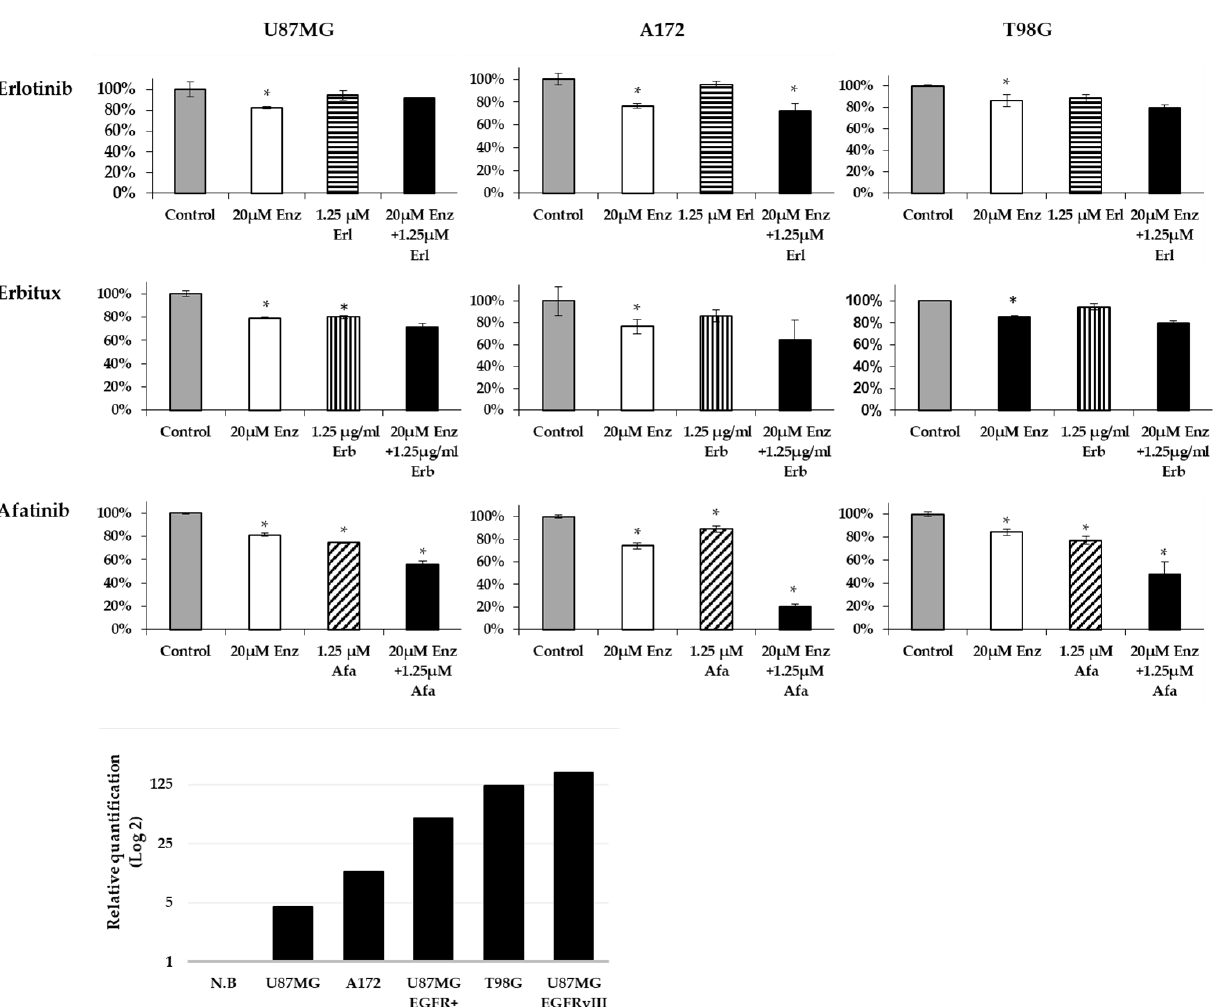
Figure 7. The combination effect of an AR antagonist and EGFR inhibitors on glioblastoma cell lines. ( A ) U87MG, A172, and T98G glioblastoma cells were treated for 72 h with EGFR inhibitors (striped columns): erlotinib (Erl), erbitux (Erb), afatinib (Afa), or the AR antagonist, enzalutamide (Enz; white columns), alone or in combination (black columns). Cell density is expressed as the percentage of cells treated with vehicle (gray columns). All experiments were repeated at least three times. The results are the mean ± SD. * p < 0.05 indicates significant results of each treatment compared to vehicle-treated cells (Student’s two-tailed t -test). ( B ) qPCR analysis results of the HPRT-normalized relative quantification of EGFR mRNA expression in the glioblastoma cells versus expression in a commercial RNA mixture of 23 normal brains (N.B).